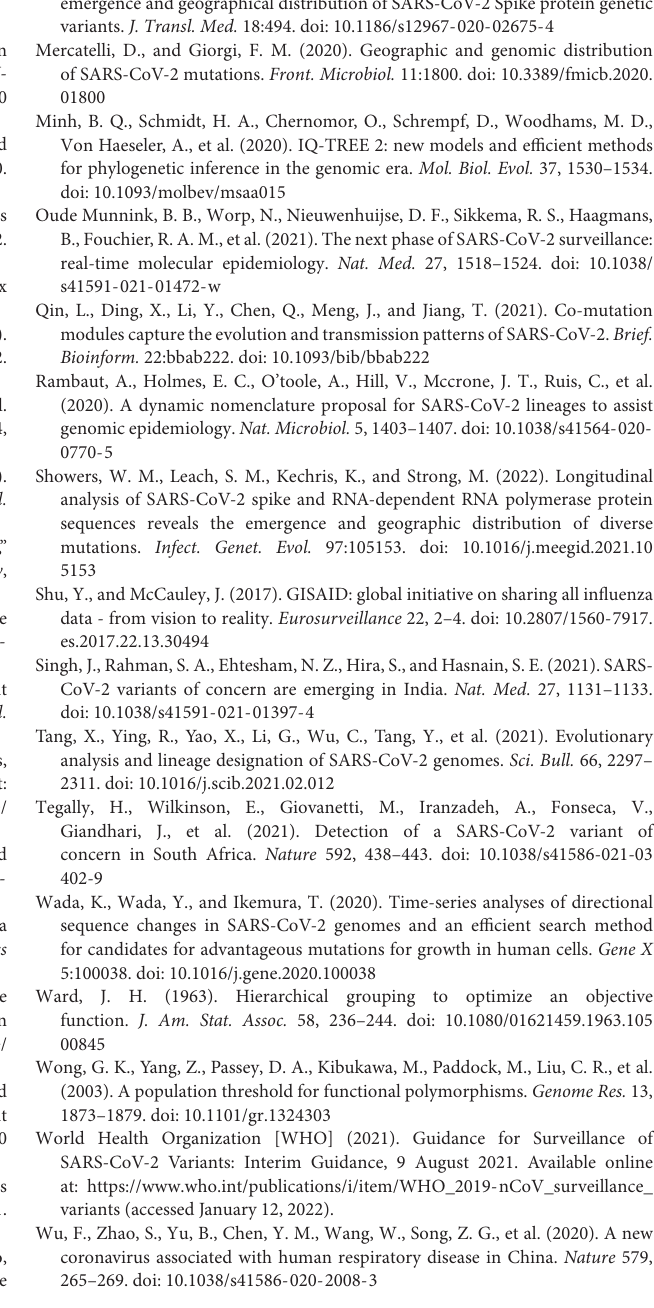
edges colored by the GISAID clade nomenclature system. (B) Comparison of the genome classification consistency between the expectation and those determined by the “core” mutations. Supplementary Figure 6 | Clustering dendrogram of 165 FTMs from India, with dissimilarity based on topological overlap. The module numbers were labeled and module clusters were highlighted with different colors. Supplementary Figure 7 | Clustering dendrogram of 223 FTMs from South Africa, with dissimilarity based on topological overlap. The module numbers were labeled and module clusters were highlighted with different